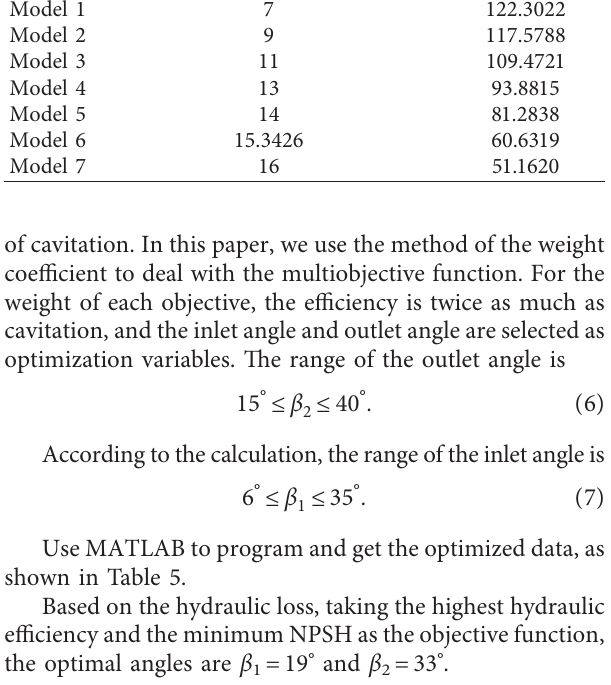
Table 3: Parameters of impeller models. Model Inlet angle β 1 ( ° ) Wrap angle φ ( °